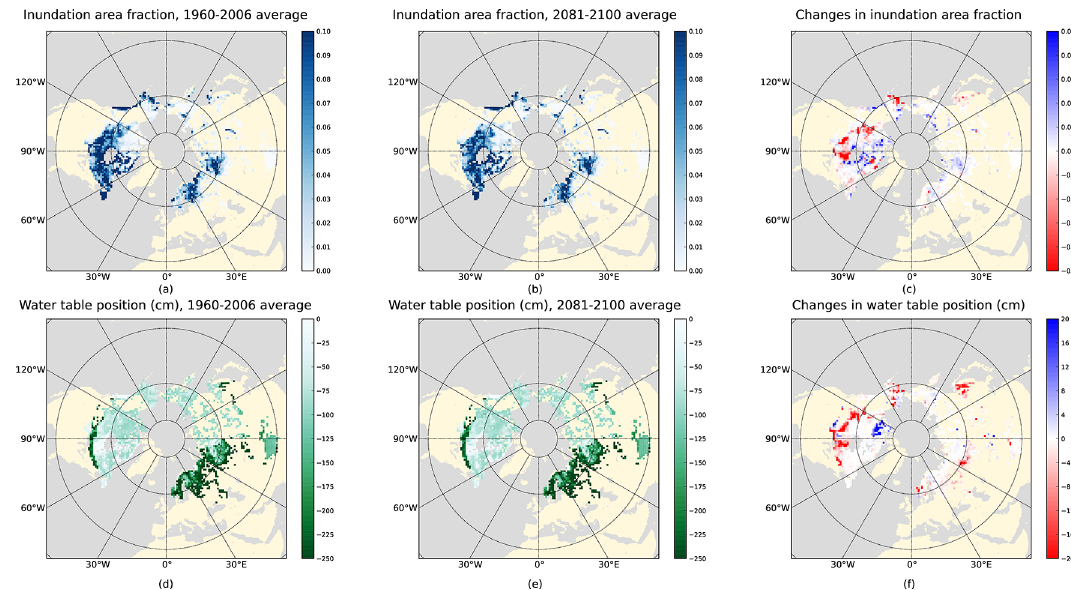
Figure 13. Changes in inundated area fraction and water table position during the historical period (1960–2006) and projection period (2081– 2100) for the process-based projection. Panel (a) is the average inundation fraction during 1960–2006, (b) is the average of 2081–2100, (c) is the difference between these two averages (b–a) . Panels (d–f) are similar for water table